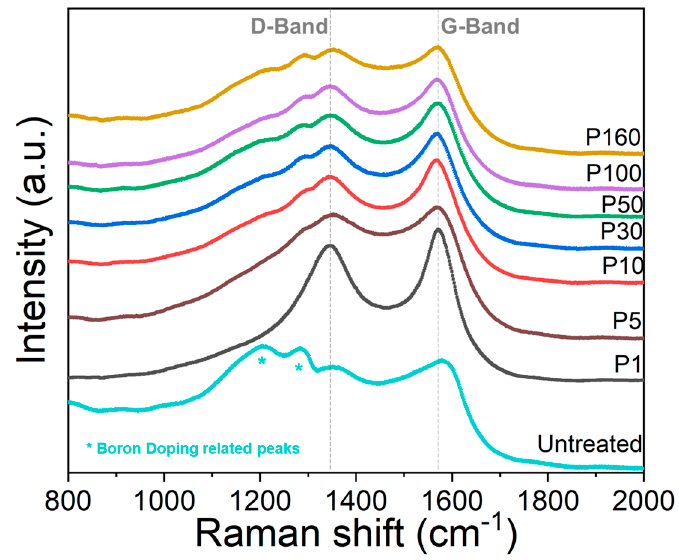
Figure 9. Raman spectra of all the samples listed in Table 1, together with the spectrum of the untreated sample. D band at ~1360 cm − 1 and G band at ~1590 cm − 1 are highlighted with dotted grey lines.